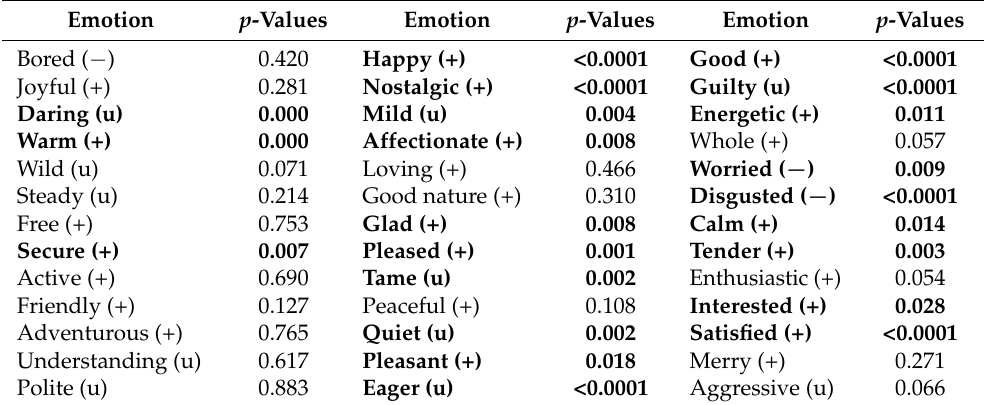
Table 2. Cochran’s Q test for the comparison of emotion elicitation by cake type for each emotion term.